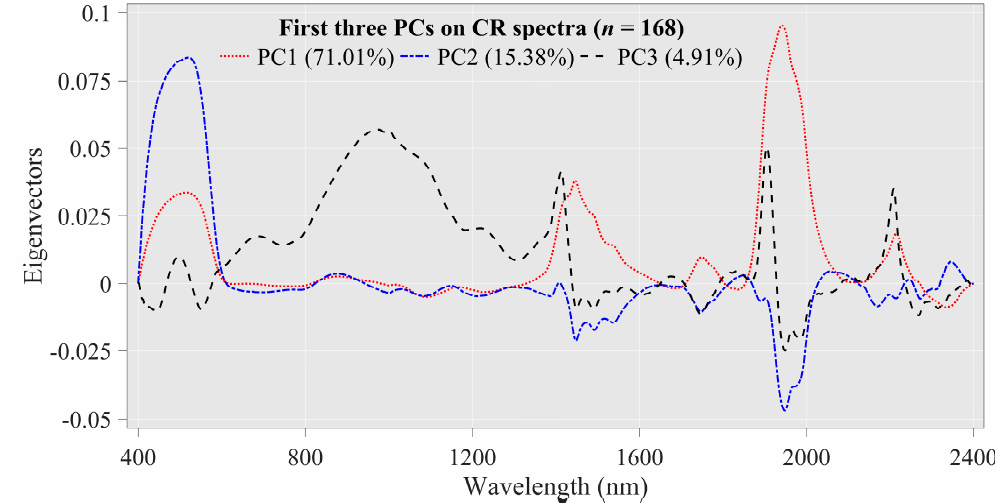
Figure 4. Eigenvector of the first three principal components derived from removal spectra ( n = 168).